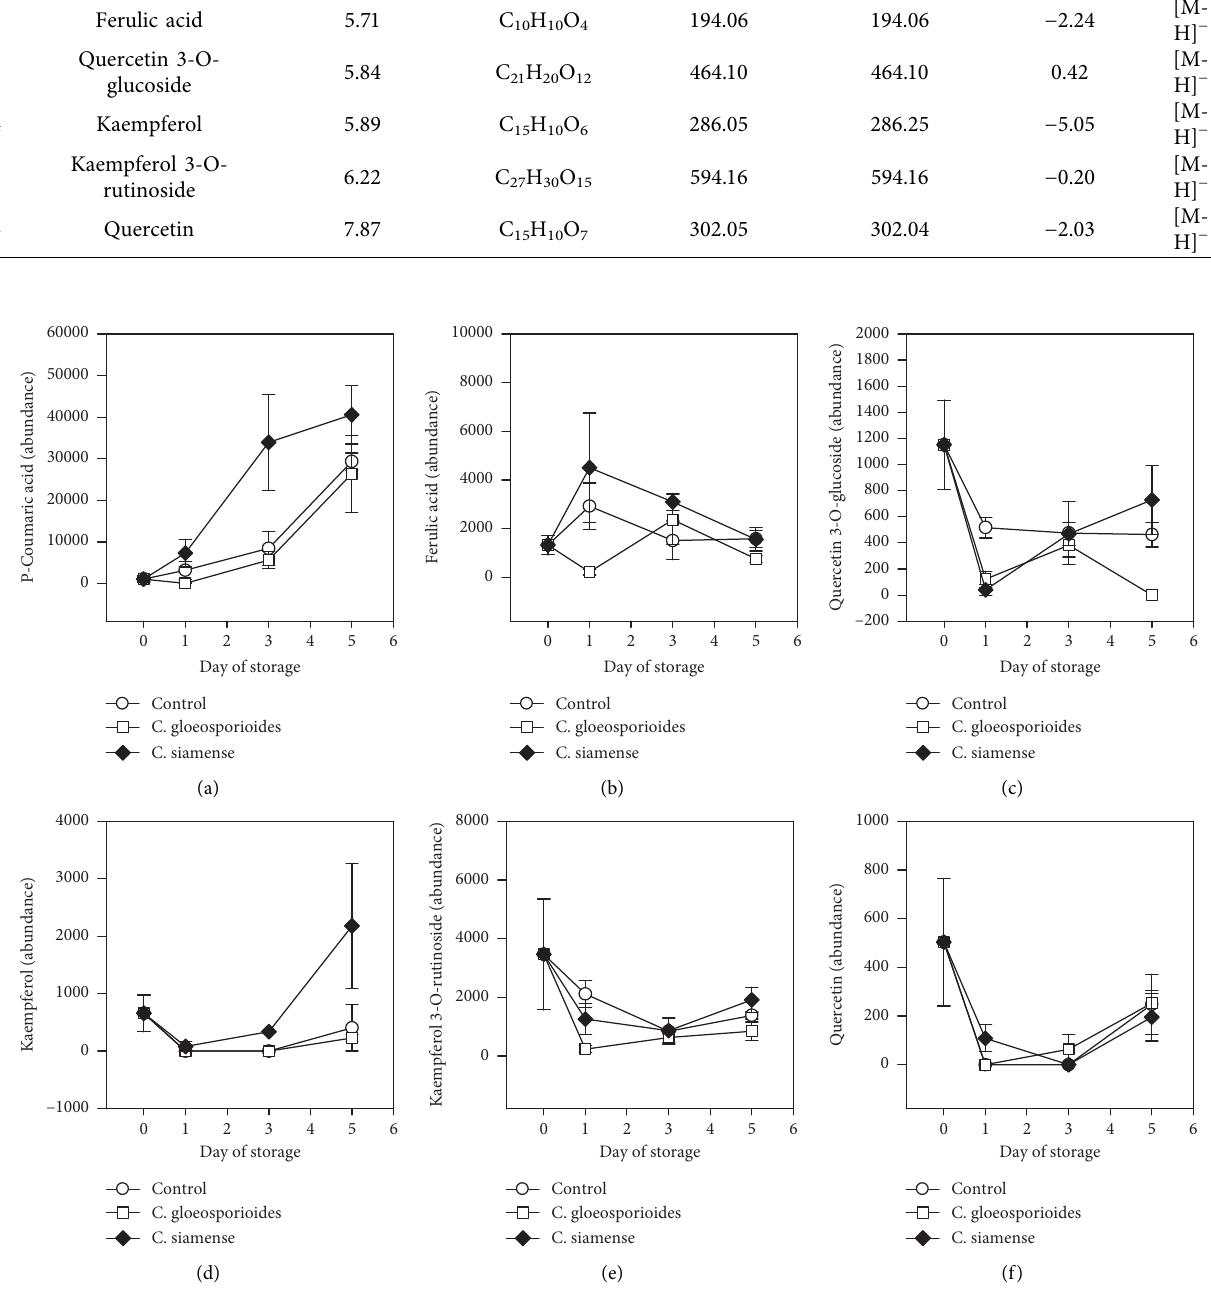
Figure 5: p-Coumaric acid (a), ferulic acid (b), quercetin 3-O-glucoside (c), kaempferol (d), kaempferol 3-O-rutinoside (e), and quercetin (f) abundance in soursop fruits with three different treatments during storage. Control ( C ), C. gloeosporioides , and C. siamense